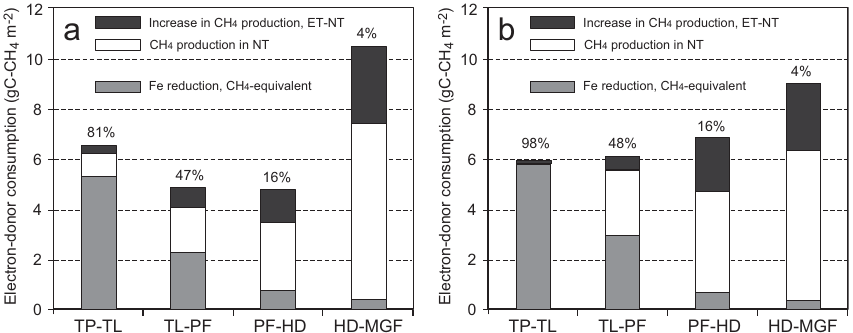
Fig. 4. Electron-donor consumption by Fe reduction and CH 4 production during four different growth periods (see Table 1 for definitions of the abbreviations) (a) 2007; (b) 2008. The CH 4 production values (not adjusted for Fe reduction) were averaged over the CO 2 treatments. Numbers on top of the bars indicate percentage of Fe reduction relative to total electron consumption in ET. Fe reduction was assumed to be the same for NT and ET and converted into CH 4 -equivalent units so that direct comparisons with CH 4 production could be made. The exact times corresponding to the four growth periods were 0–21, 21–48, 48–78, and 78–99DAT for Fe reduction and 0–27, 27–48, 48–76,